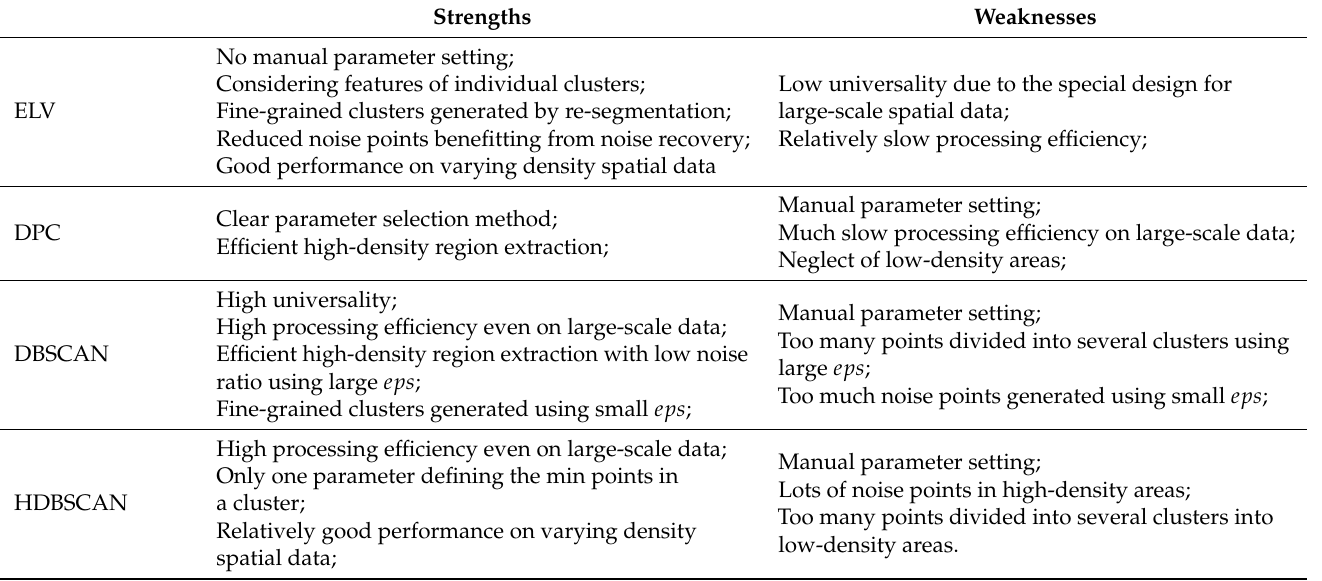
Table 6. Strengths and weaknesses of the four algorithms: our proposed algorithm (ELV), DPC, DBSCAN, and HDBSCAN. Strengths